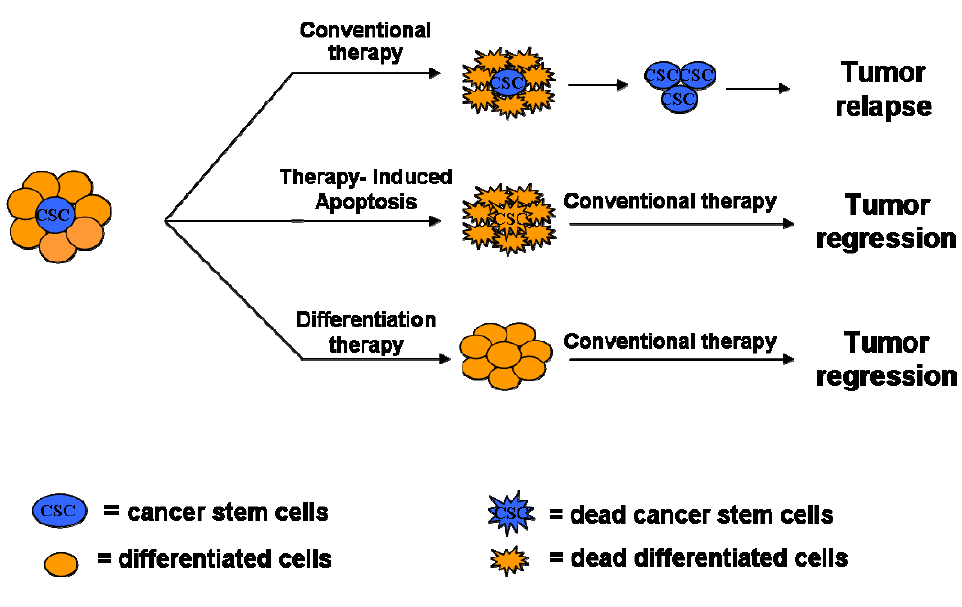
Figure 3. Therapeutic Strategies for CSCs